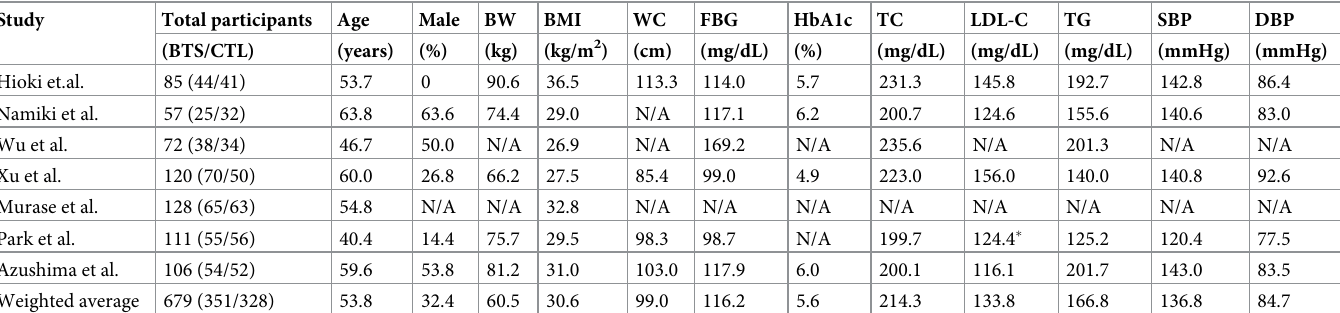
Table 2. Baseline characteristics of participants in our study.